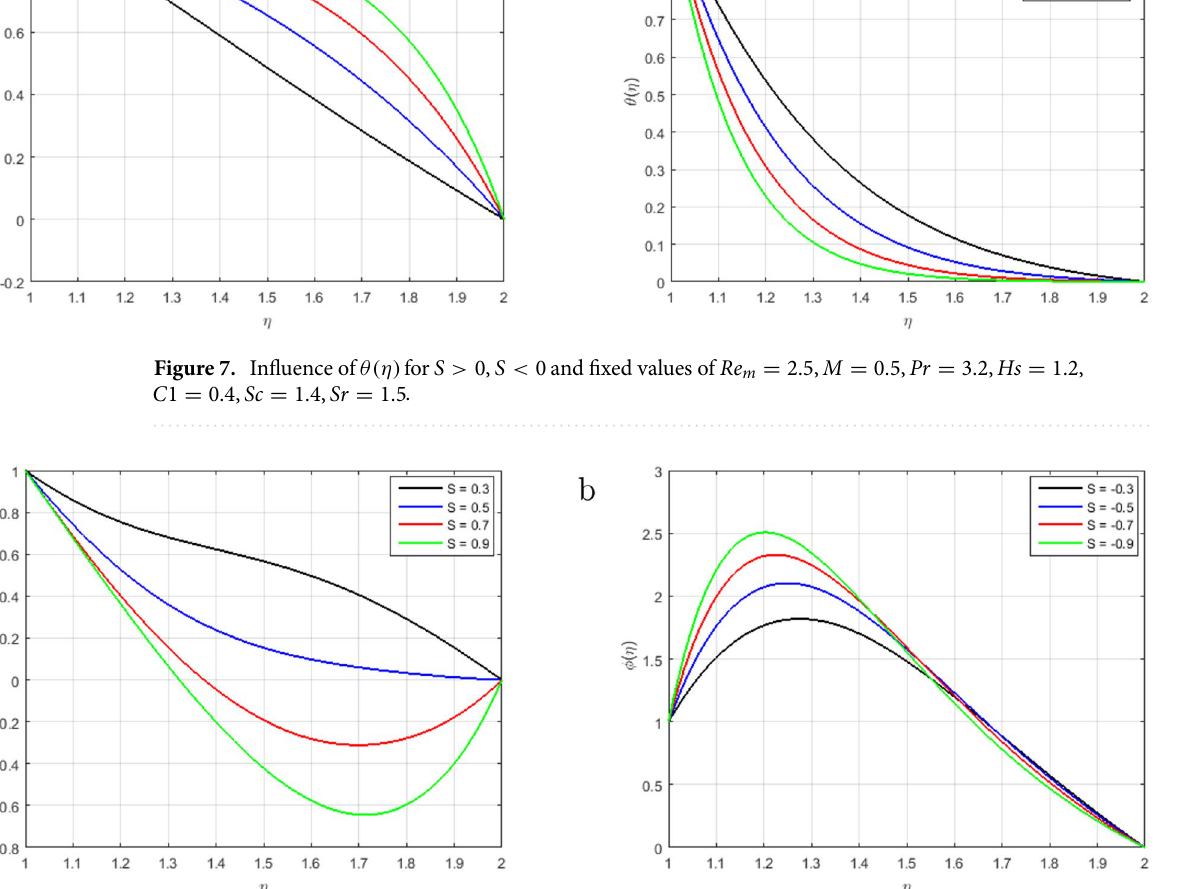
Figure 8. Influence of φ(η) for S > 0 , S < 0 and fixed values of Re m = 2.5, M = 0.5, Pr = 6.2, Hs = 1.2, C 1 = 1.4, Sc = 1.4, Sr = 2.5